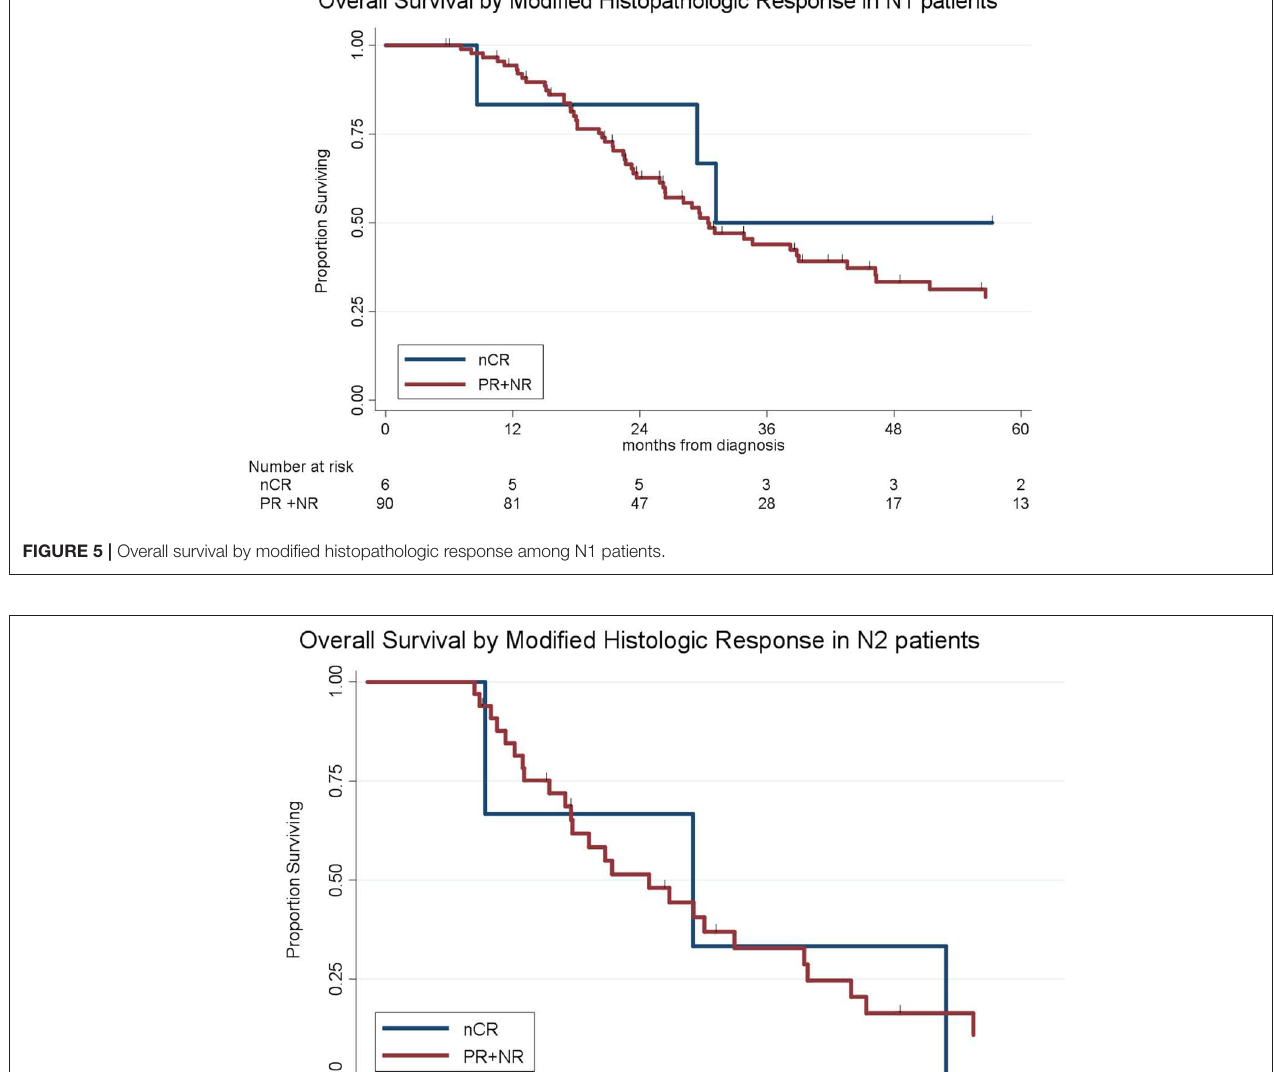
been considered a surrogate endpoint for clinical trials